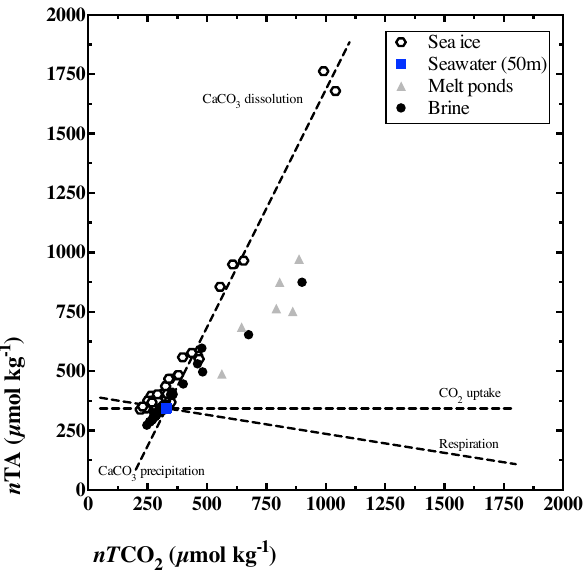
Figure 9. Relationship between the nT CO 2 and n TA (µmolkg − 1 ) in bulk sea ice (white hexagons), melt ponds (grey triangles) and brine samples (black dots). The different dashed lines represent the theoretical evolution of n TA : nT CO 2 ratio following the precipita- tion/dissolution of calcium carbonate, release/uptake of CO 2(g) and biological